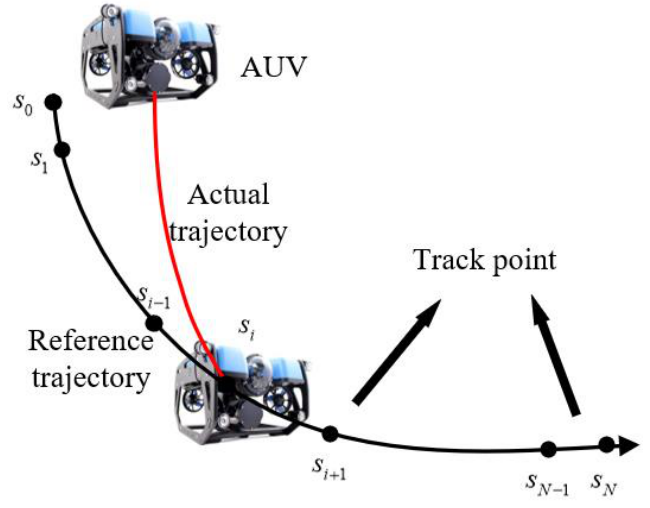
Figure 1. The trajectory tracking process diagram of underwater vehicle.